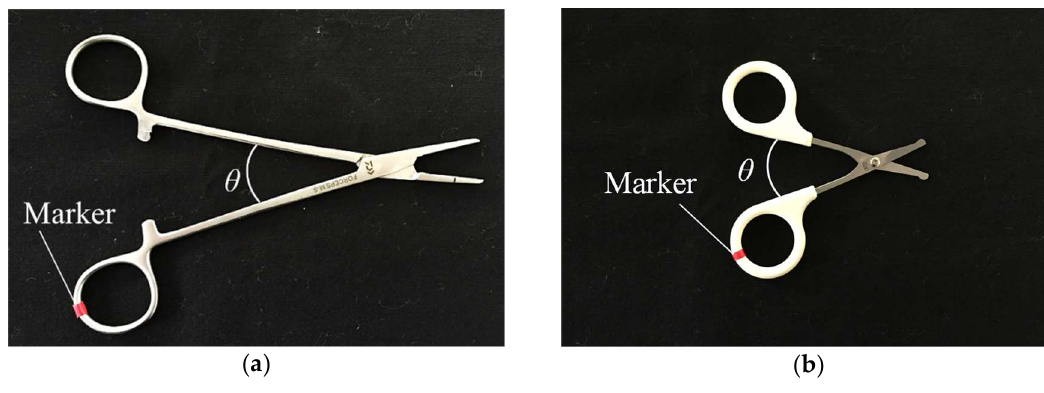
Figure 1. Photograph of the ( a ) forceps and ( b ) scissors.